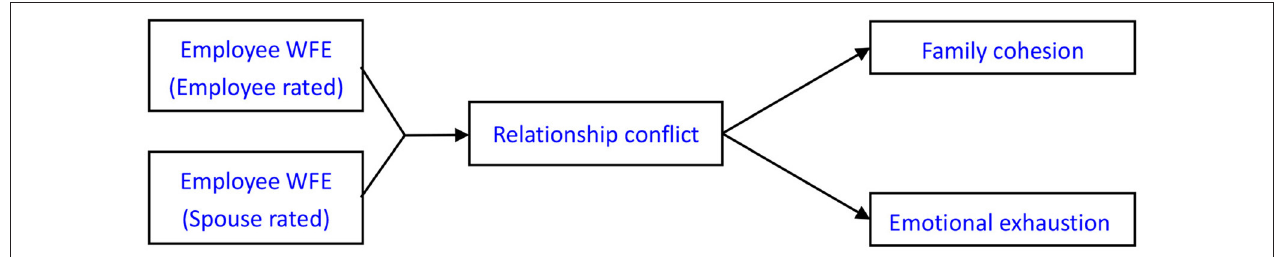
FIGURE 1 | Theoretical model for the current